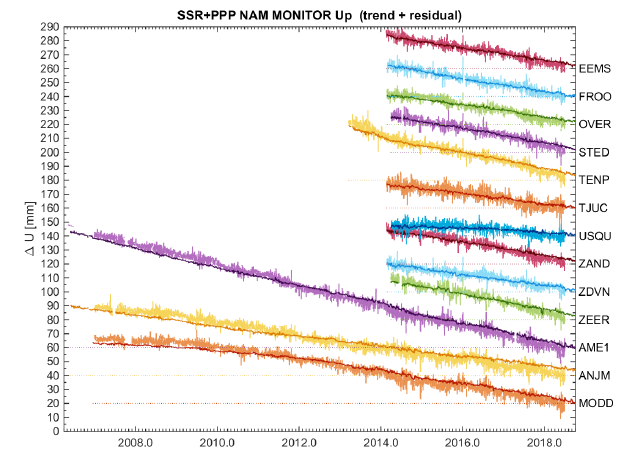
Figure 9. GNSS time series Height/Up component (relative, mm), PPP (light) and SSR (dark) solution.